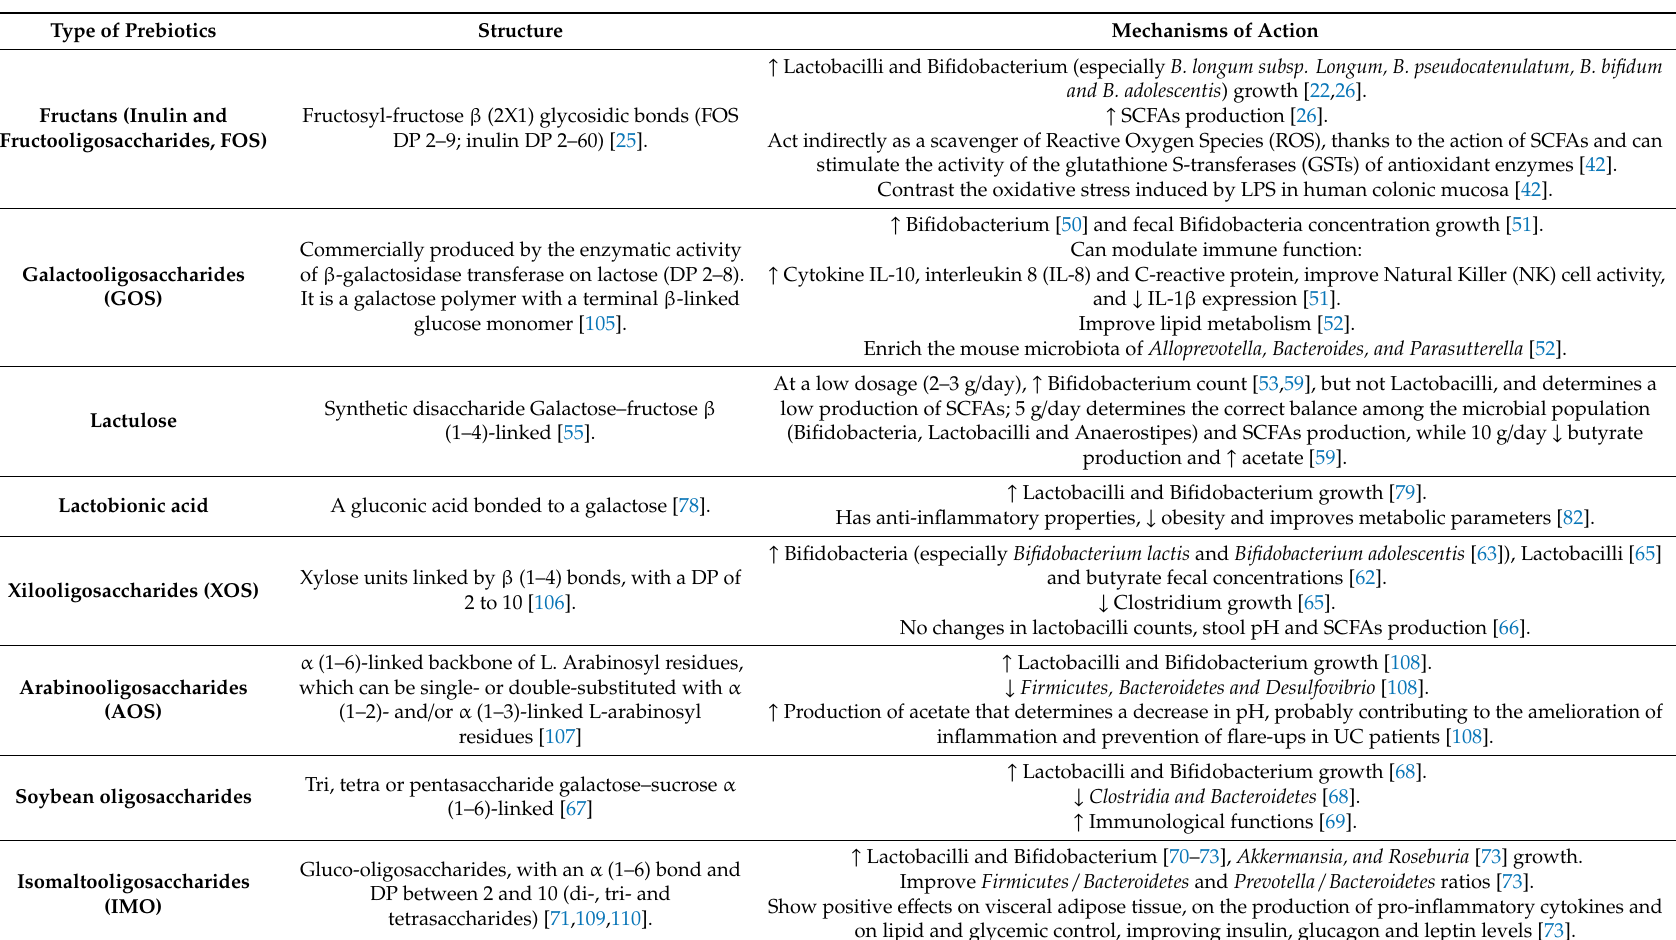
Table 2. Mechanisms of action of